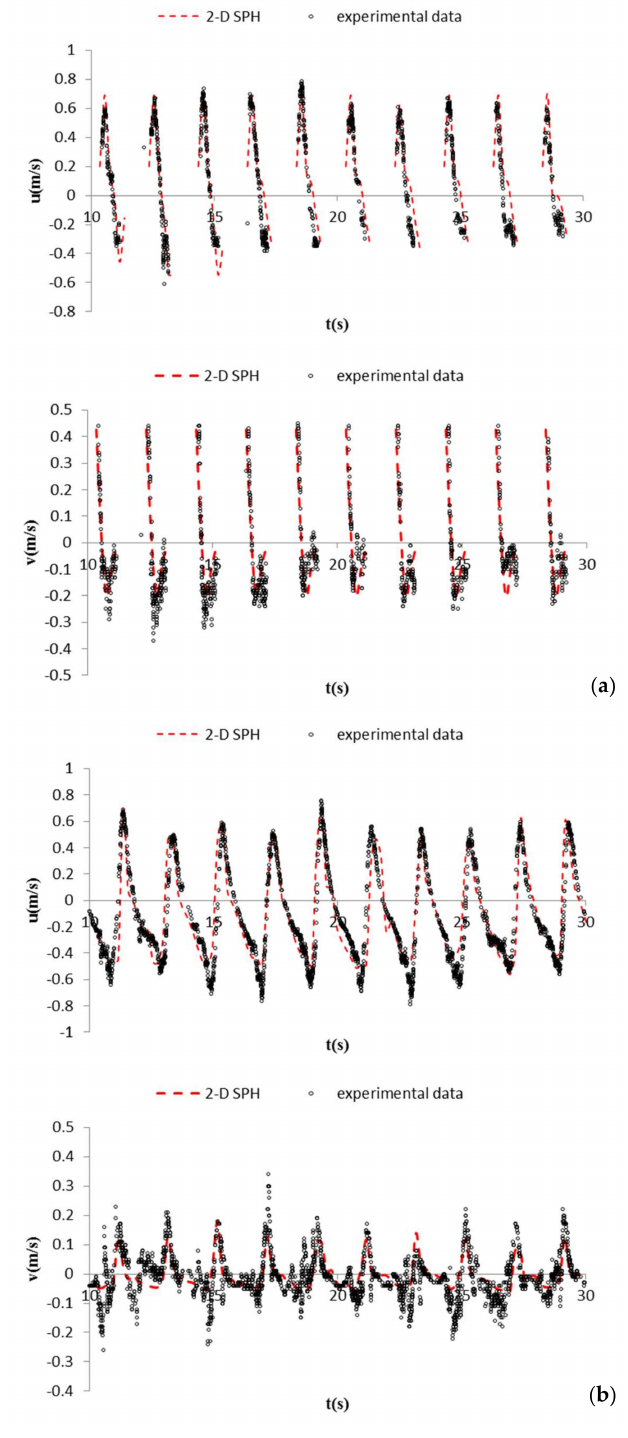
Figure 6. Time series of the horizontal and vertical velocity components at Section 0, ( a ) near the surface, at 1 cm from the SWL and ( b ) near the seabed, at 10c m from the